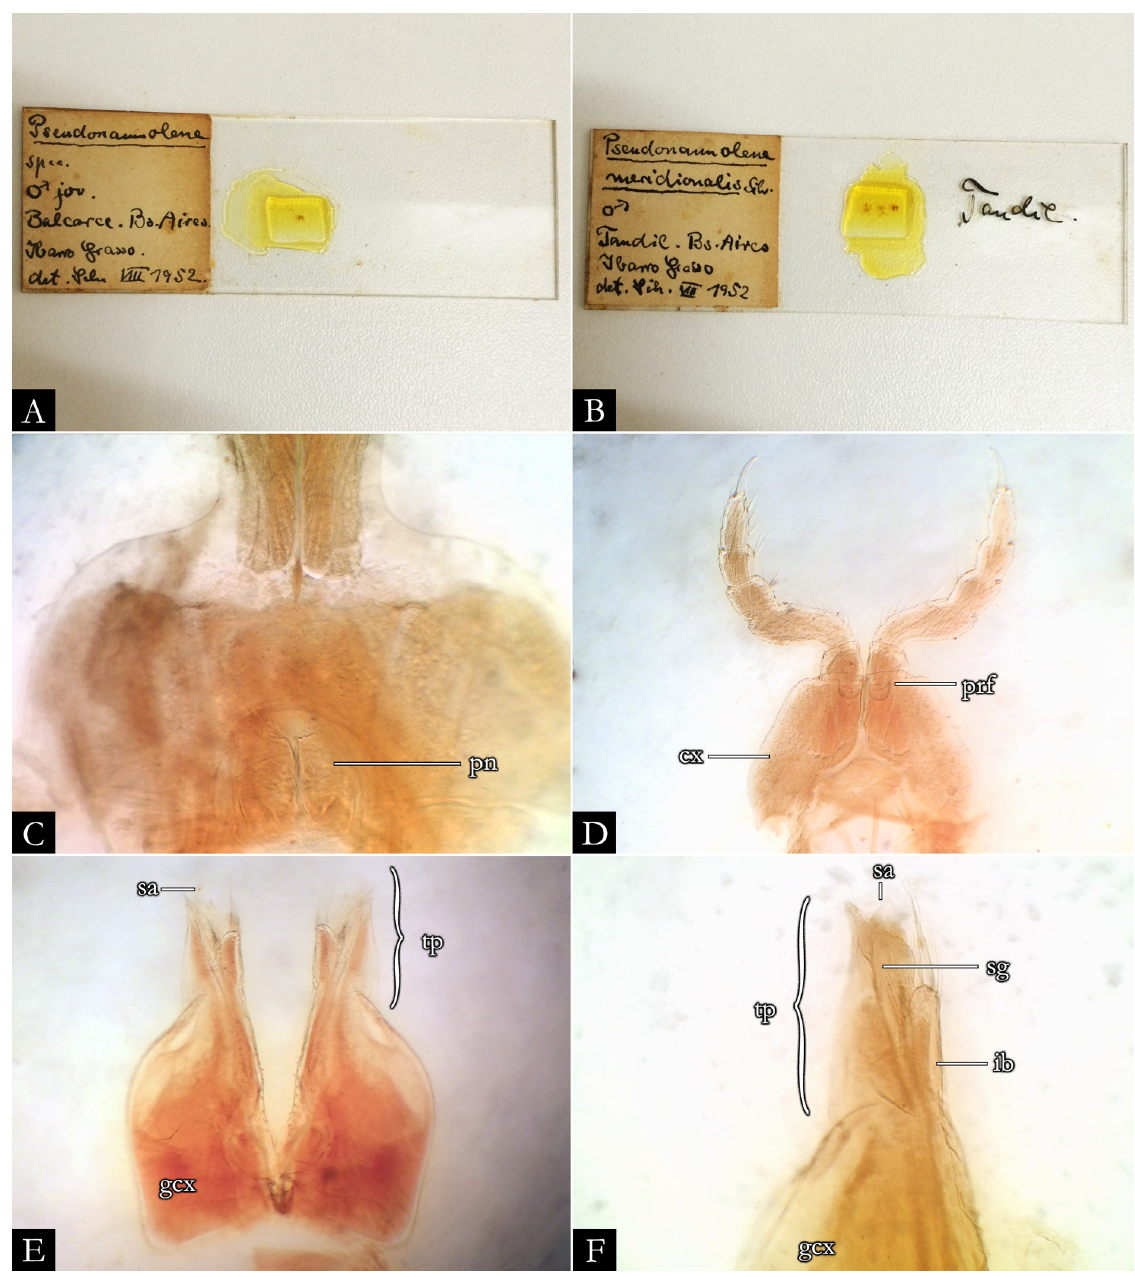
Fig. 120. Pseudonannolene scalaris Brölemann, 1902, ♂ (MZSP). A . Gonopods of immature ♂ mounted on microscope slide. B . Sexual structures of ♂ adult mounted on microscope slide. C . Detail of penis. D . Second leg-pair. E . Gonopods, in anal view. F . Detail of telopodites, in anal view. Abbreviations: see Material and methods. Images not to